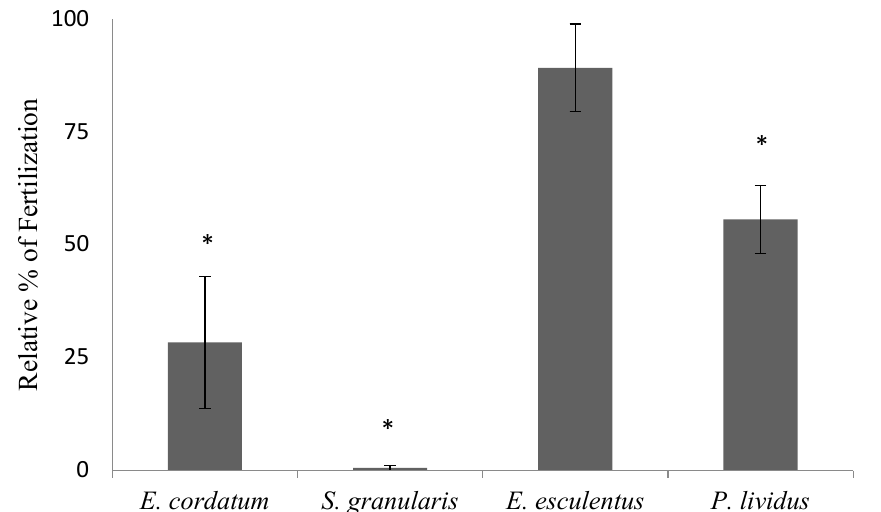
Figure 4. Relative percentage of fertilization, mean ± SD, obtained with sperm that had been cryopreserved using 1.5 M Me 2 SO for four species of sea urchins (n = 3 individuals), using a floating rack at 5 cm above liquid nitrogen. Sperm to egg ratio was constant at 10–20:1, and contact time allowed was 15 min before the fertilization assessment. (Controls showed 60 ± 10%, 35 ± 5.5% (unusually low), 95 ± 3% and 98 ± 2.1% fertilization, respectively). Asterisks show significant differences with their specific controls ( p ≤ 0.05).